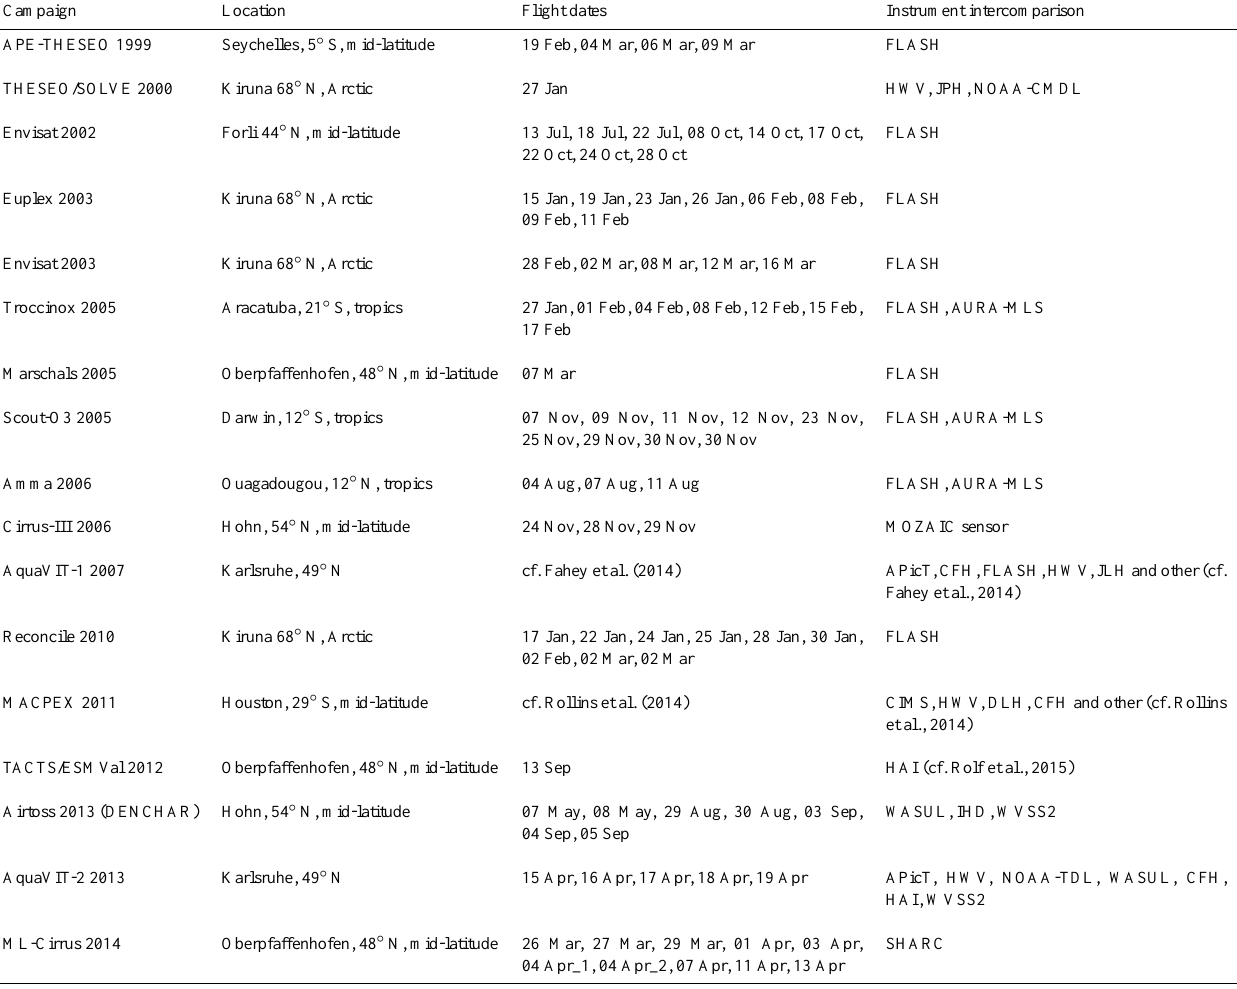
Table 1. List of all campaigns where FISH performance is compared to other instruments (for a list of instruments, see Table 2). Campaign Location Flight